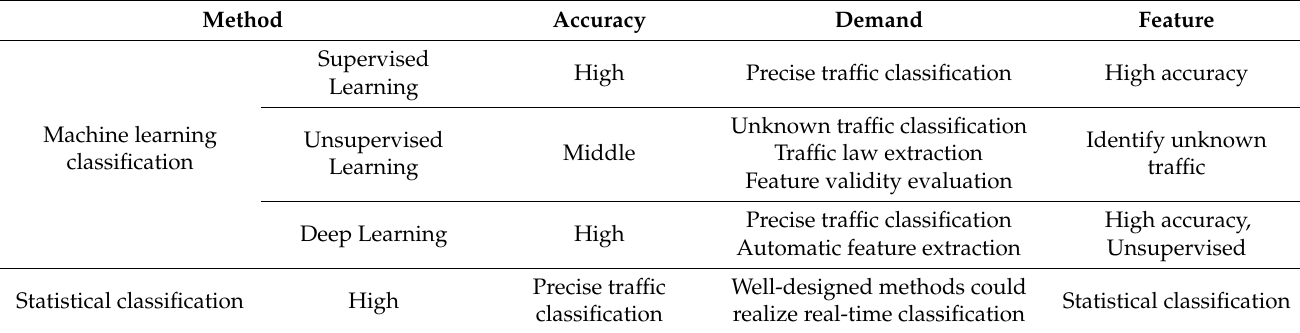
Table 14. Comparison of two types of